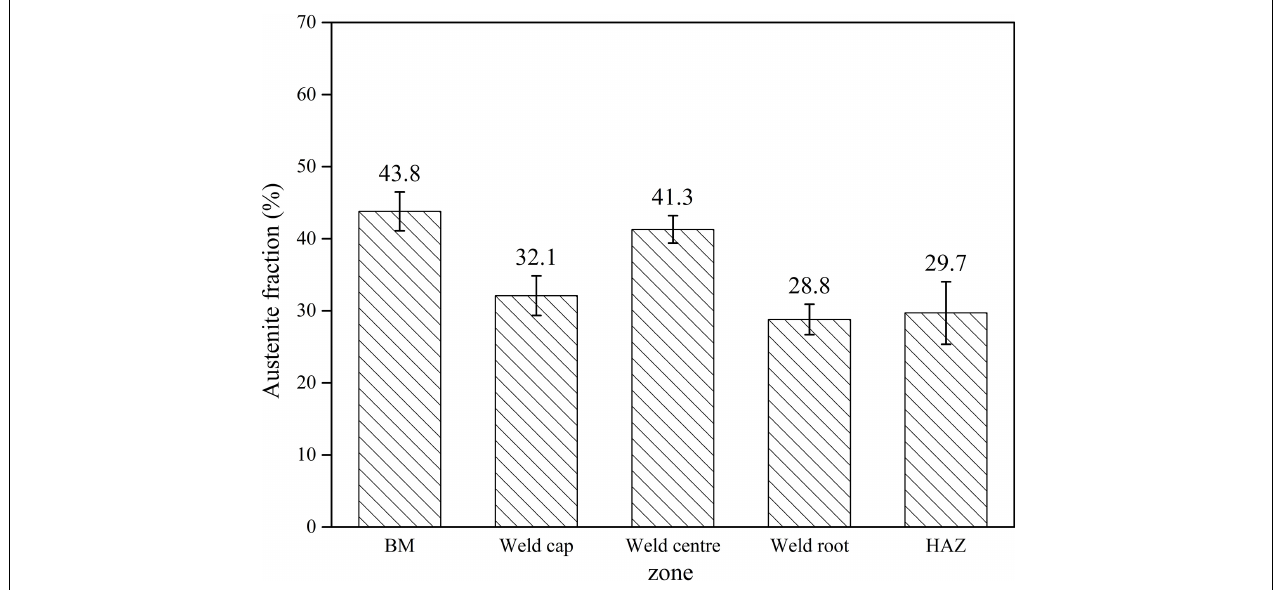
FIGURE 3 | The average austenite contents in different zones of the weld joint counted by